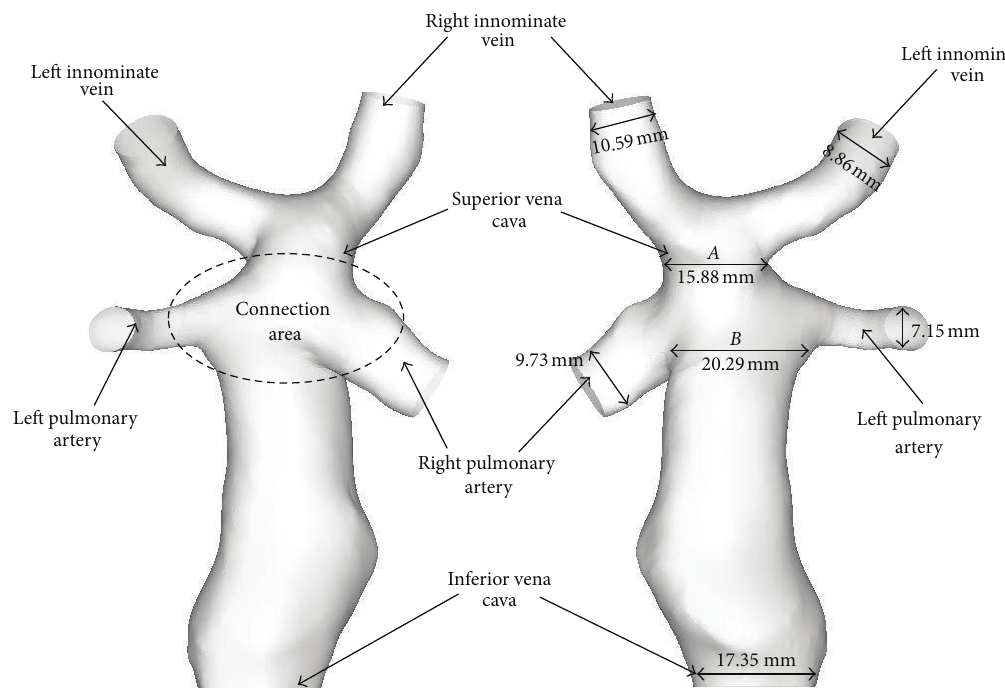
Figure 2: The patient-specific three-dimensional reconstructed configuration after surface smoothing.